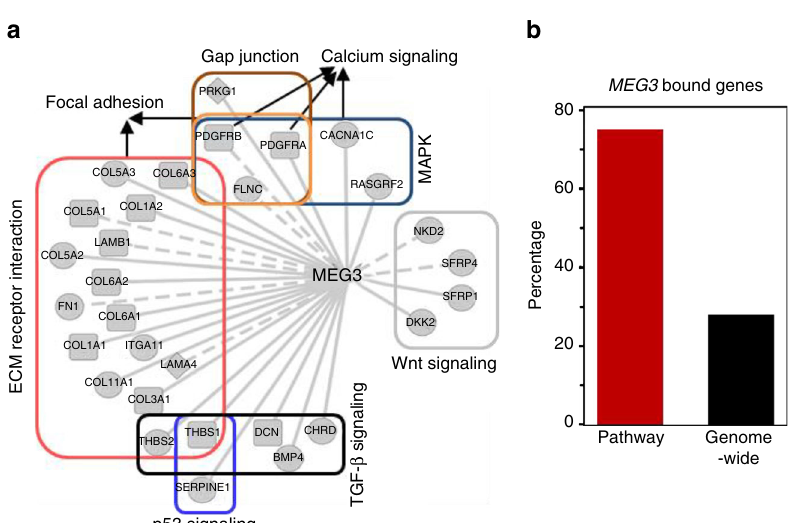
Fig. 3 MEG3 preferentially targets EMT-linked genes. a EMT-linked pathway genes having MEG3 binding sites are represented by solid lines; remaining genes represented by dashed lines. Nodes with circle, diamond, and rectangle shapes represent predicted MEG3 regulated genes as inferred from TCGA, GSE9891, or both data, respectively. b Enriched number of predicted MEG3 regulated EMT-linked pathway genes had MEG3 binding sites compared to the all known human